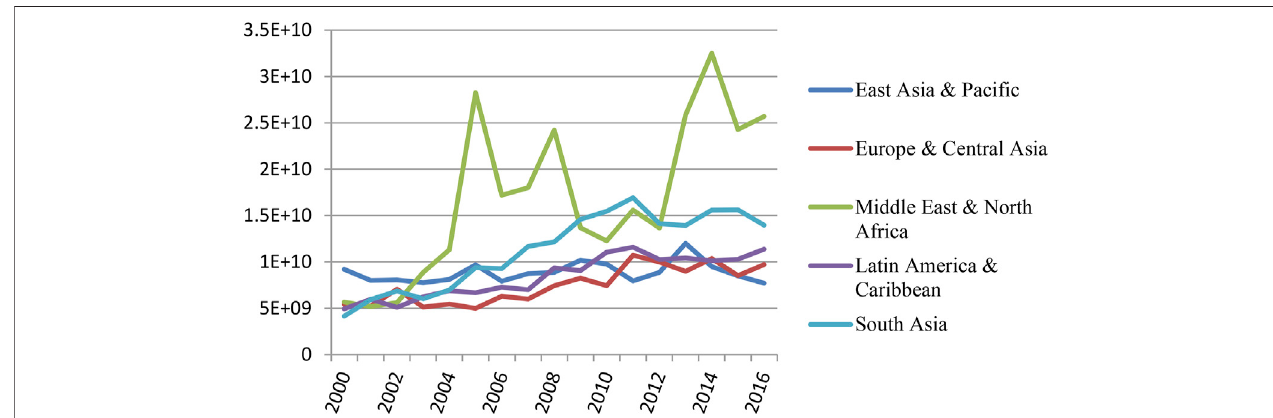
FIGURE 5 | Net Of fi cial Development Assistance in different regions. Source: Penn world table 9.0 (2016).